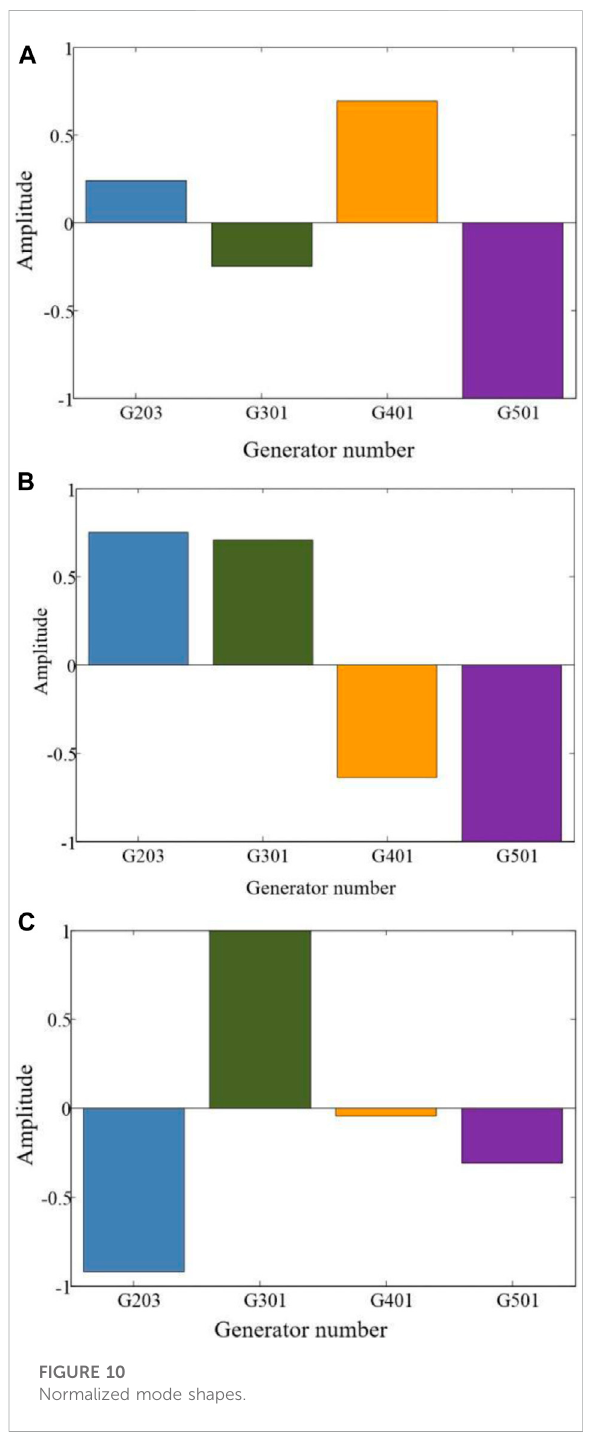
FIGURE 10 Normalized mode shapes.